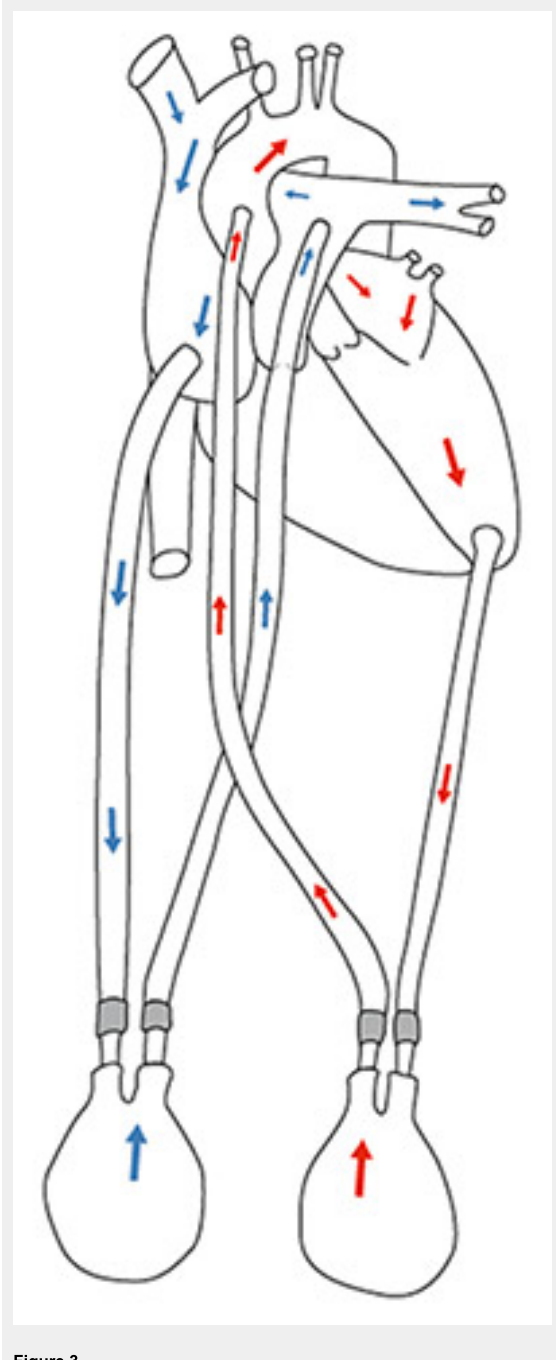
Figure 3 Schema of the BVAD Berlin Heart (blue arrows = venous blood flow, red arrows = arterial blood flow). (Property of Julia Schrempf, Graz,